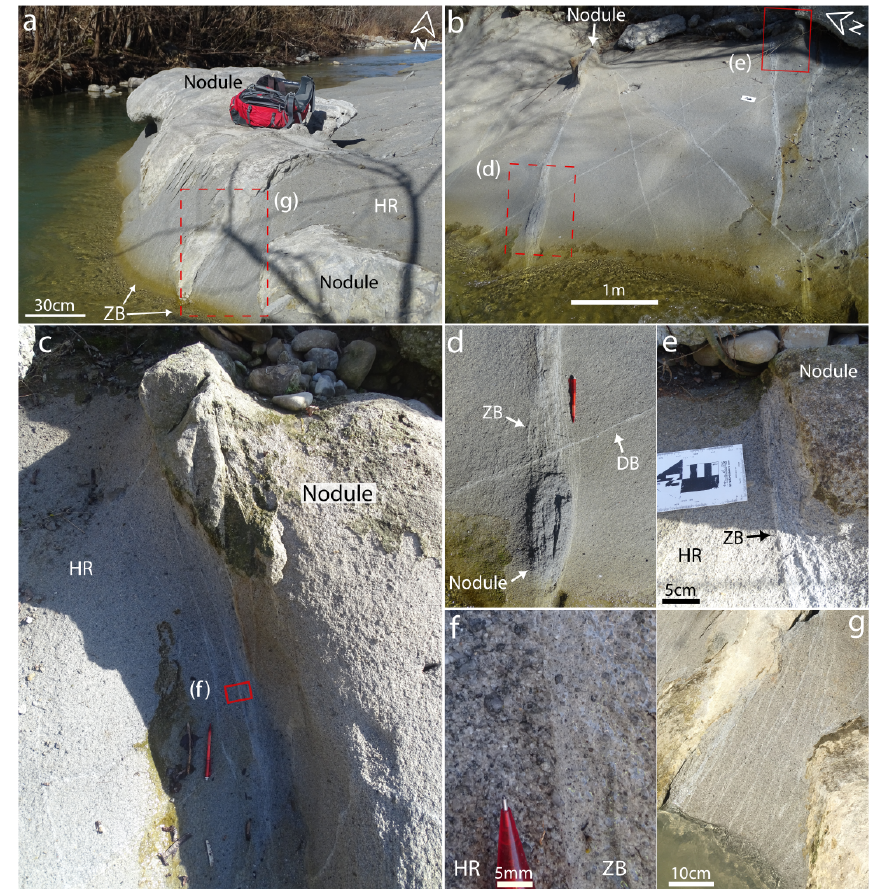
Figure 4. Relationships between nodules and DBs. Deformation bands occur either as single structures or organized in clusters (ZB). Nodules along DBs (or ZB) are isolated (b, d, e) or continuous with a tabular geometry (a) . Nodules are located along the DB trace (a, b, d) , or they are asymmetrically placed on a side of the DB (c) . (e) Isolated nodule in between and confined by ZB. DBs are whiter than host rock and exhibit a positive relief, a clear reduction in grain size, and a lower porosity visible to the naked eye (f) . The pen in (c, d) is 14cm in length. The arrow scale in (b, e) is 10cm in length. The position of (a, b) is indicated in Fig. 3.